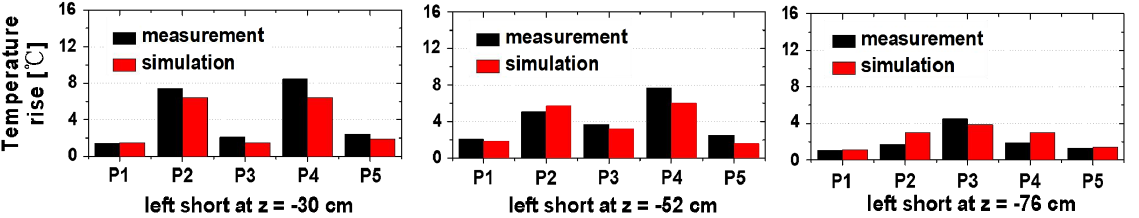
FIG. 21. Temperature rise at the monitored positions of the proof-of-principle structure with 2.5 kW of power inside the cavity. The ambient temperature is around 27 °C.